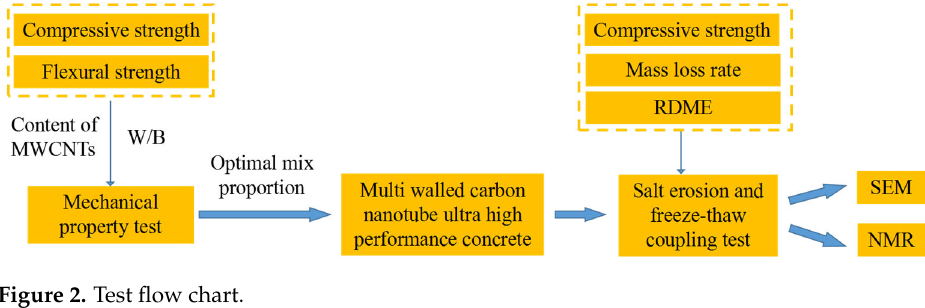
Figure 2. Test flow